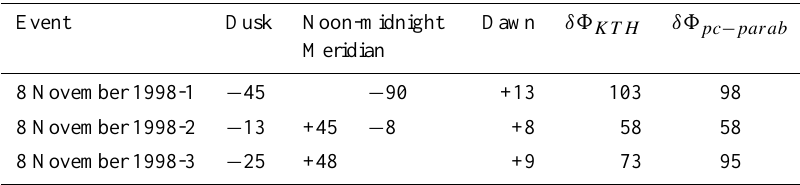
Table 2. Local potential extrema (kV) for 8 November 1998. Event Dusk Noon-midnight